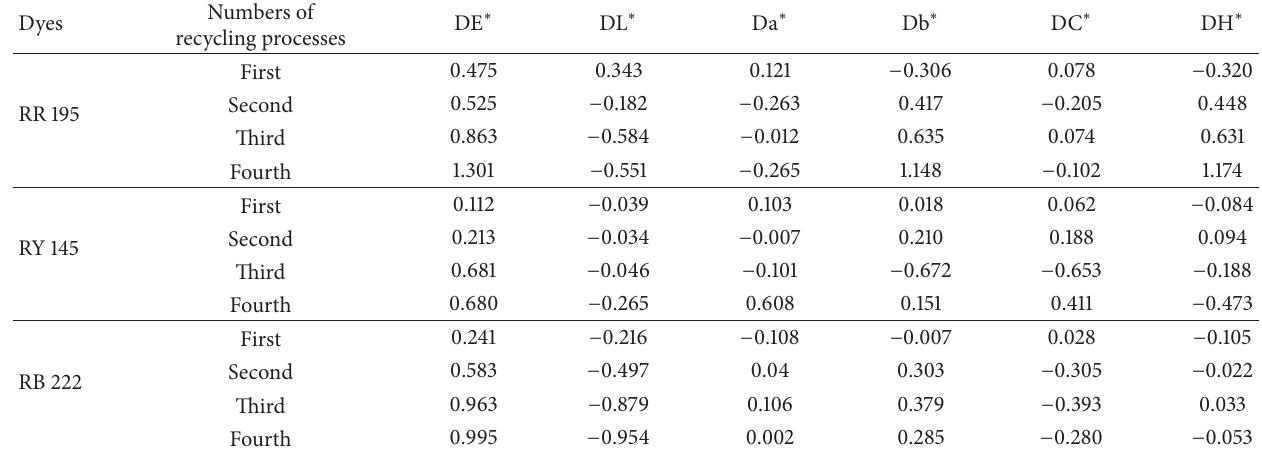
Table 3: Color differences of three dyed fabrics with respect to control samples.